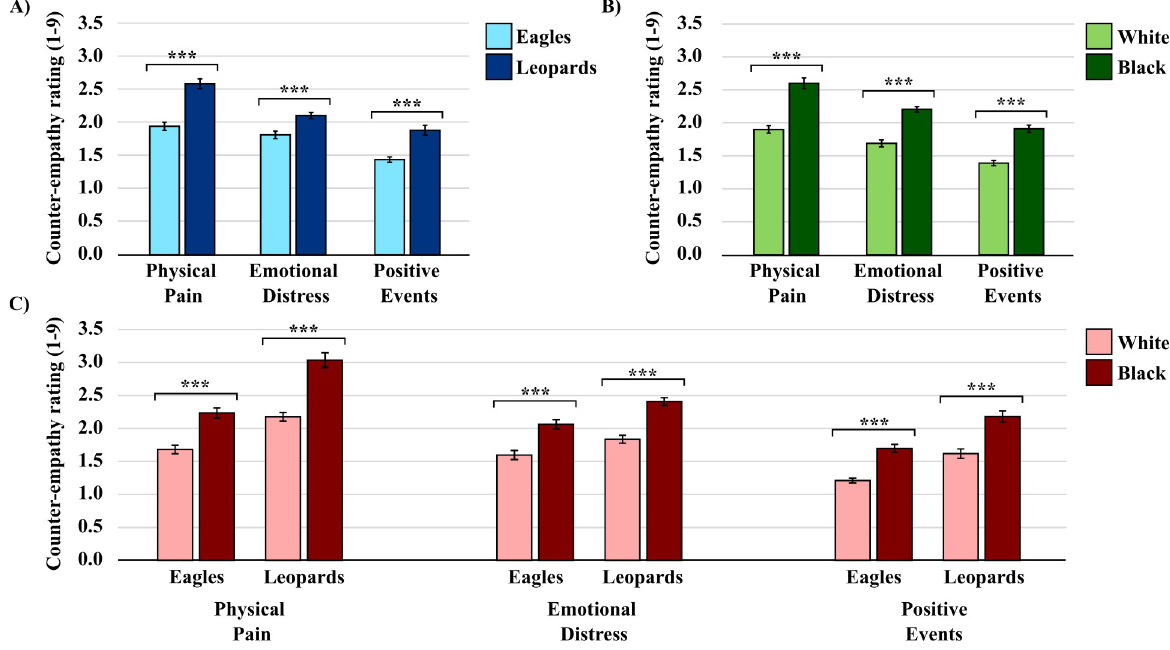
Fig 4. Self-reported counter-empathic ratings in response to physically painful, emotionally distressing, and positive events. Counter- empathic ratings for (A) ingroup (Eagles) versus outgroup (Leopards) teams, for (B) White versus Black African team members, and for (C) Team x Race interactions. Counter-empathic ratings in response to physically painful and emotionally distressing events were determined by how “good” the events made participants feel, whereas counter-empathic ratings in response to positive events were determined by how “sorry” the events made participants feel. Error bars indicate standard error of the mean. *** p <